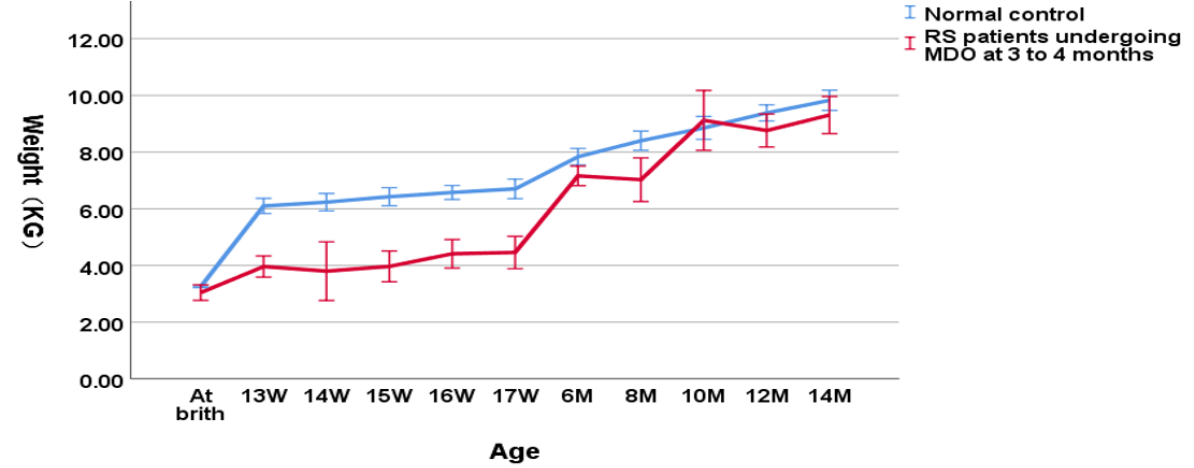
Figure 4. Wight-for-age chart(RS patients undergoing MDO at 3 to 4 months month versus normal control).